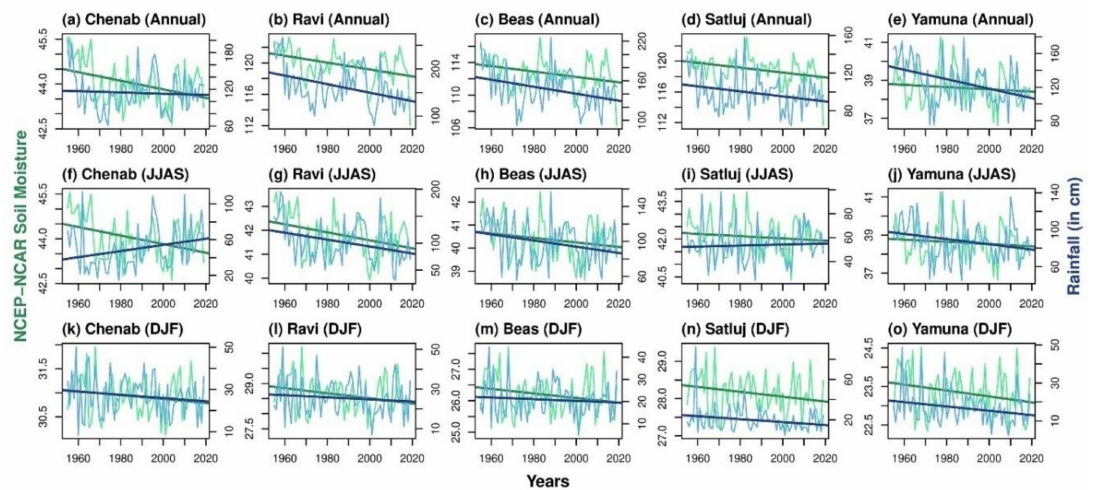
Figure 8. Basin-wise trend of mean rainfall and soil moisture for annual, JJAS, and DJF seasons for the 1955–2019